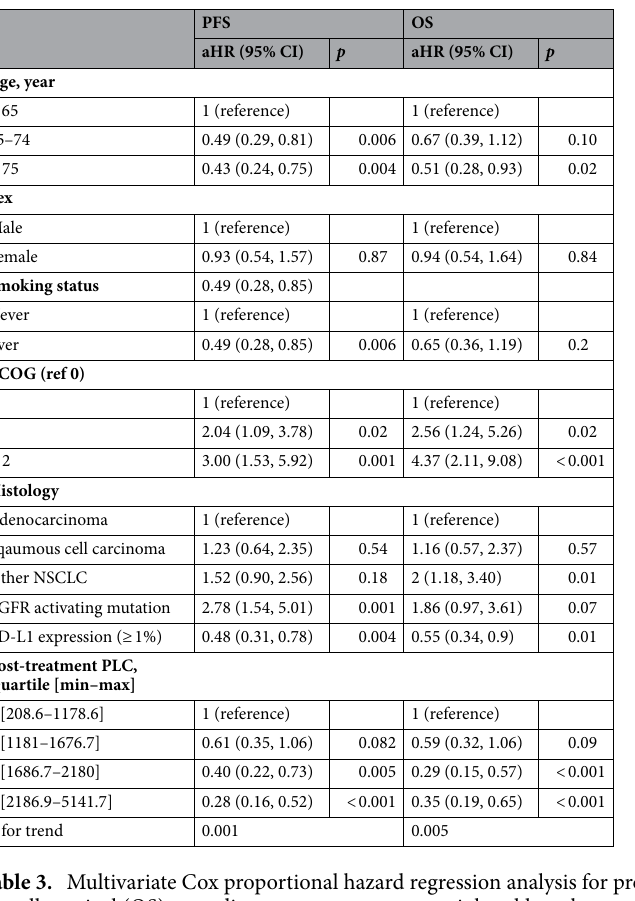
Table 3. Multivariate Cox proportional hazard regression analysis for progression-free survival (PFS) and overall survival (OS) according to post-treatment peripheral lymphocyte count. PFS, progression-free survival; OS, overall survival; aHR, adjusted hazard ratio; CI, confidence interval; PLC, peripheral lymphocyte count.